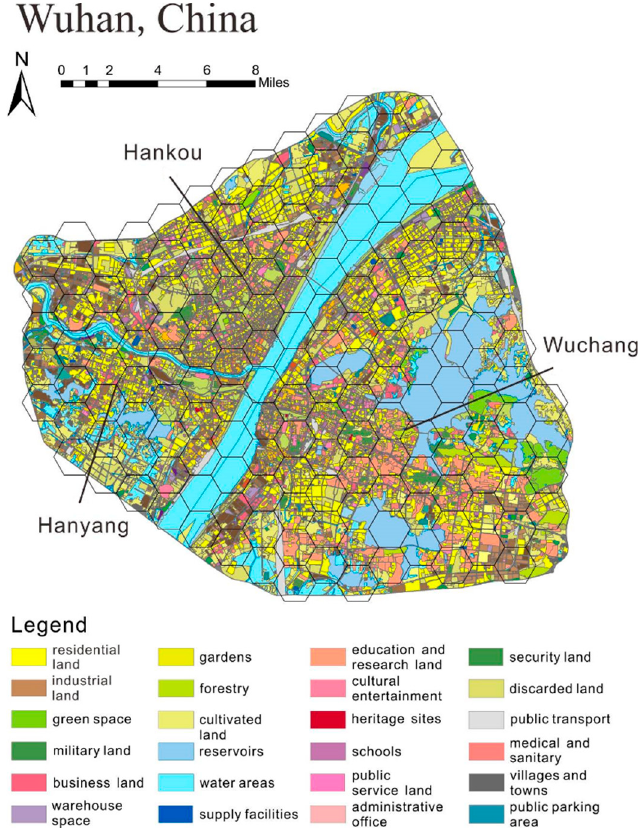
Figure 1. Current urban land use map of Wuhan, China.